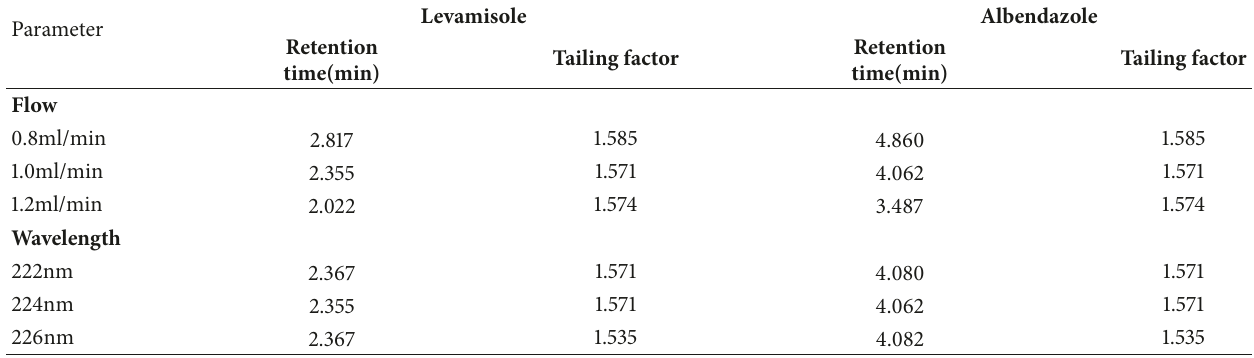
Table 5: Result of robustness